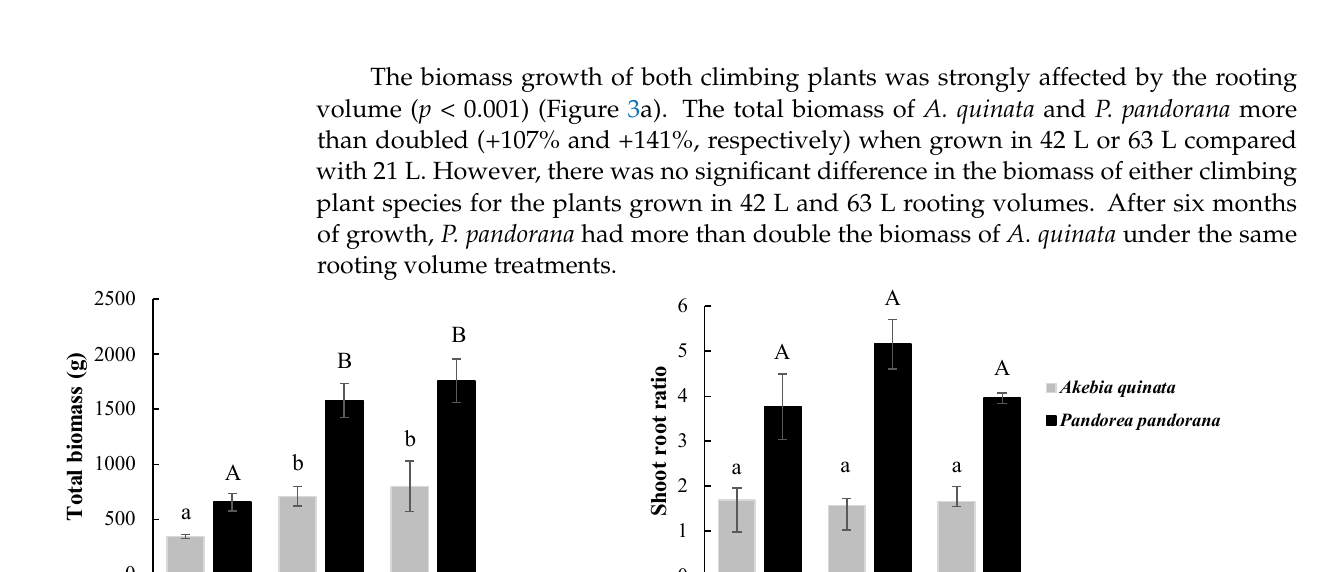
volumes after two, four, and six months of growth after transplanting. Values are means ± SE.